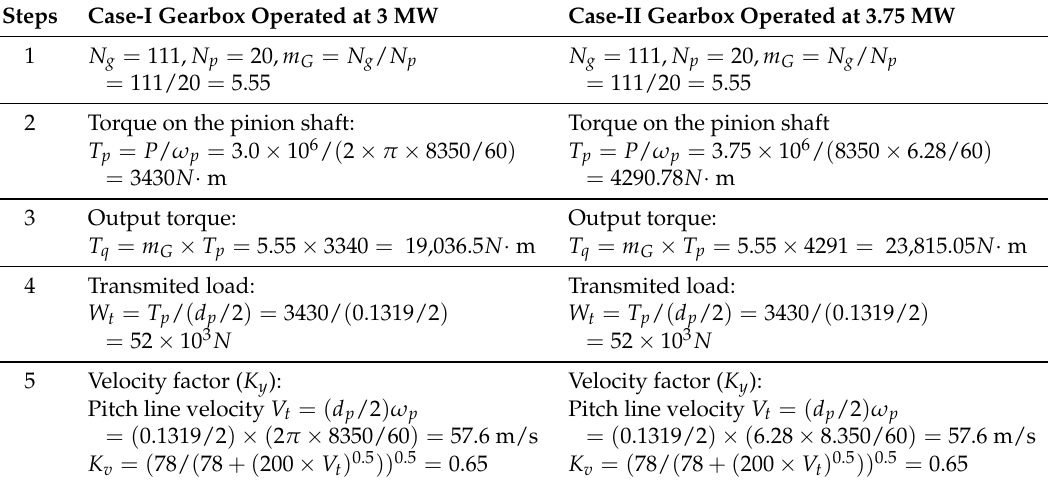
Figure 9. Isometeric view of gear pair illustrating the normal stress in y-direction. Table 2. Design checks of pinion and gear as per AGMA for assessing the safety